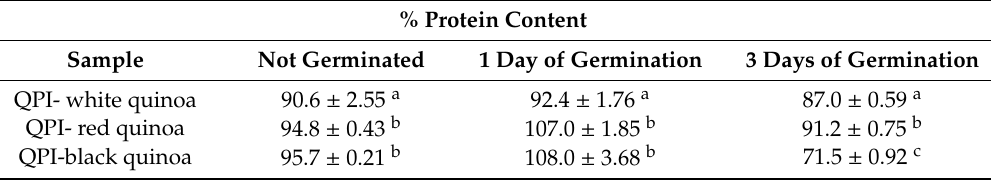
Table 1. Protein content of non-germinated QPI and germinated using the BCA method. % Protein Content